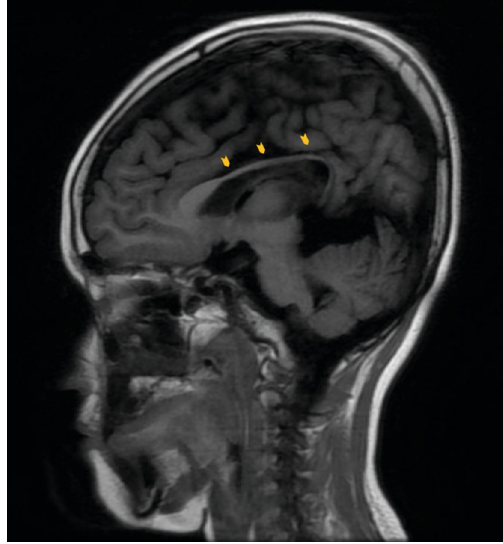
Figure 2: Sagittal slice of T1-weighted image showing dysgenesis of the corpus callosum